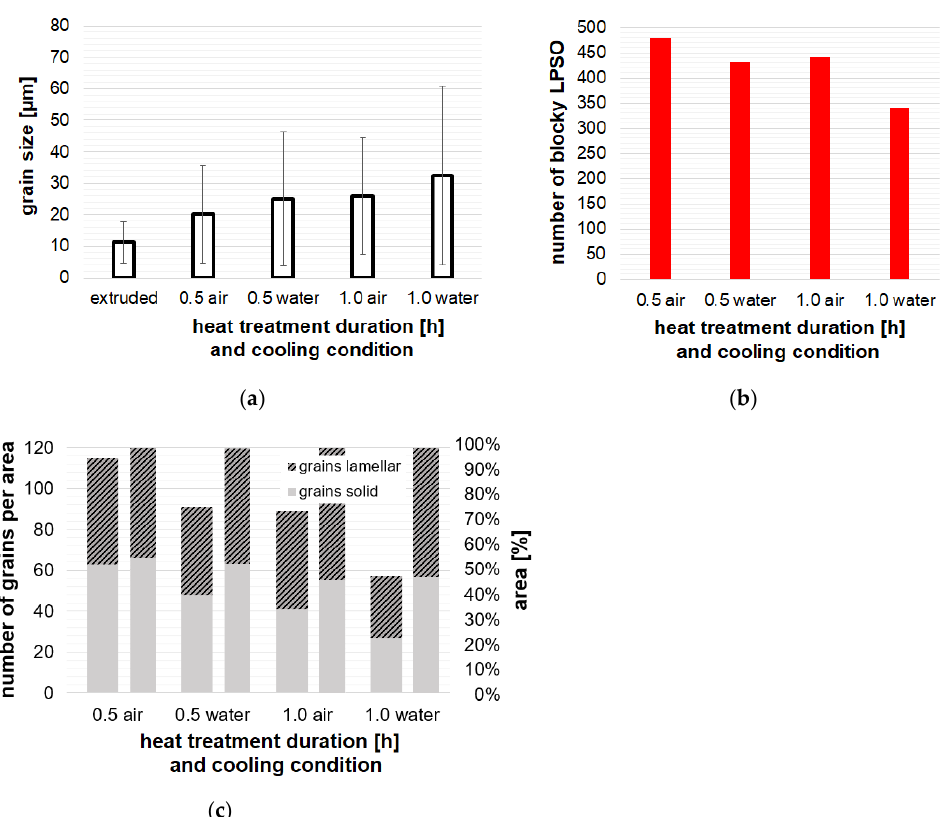
Figure 7. Microstructure depending on ( a ) grain size, ( b ) number of blocky LPSO and ( c ) number of grains per area of Mg matrix grains without LPSO lamellae (solid) and with LPSO lamellae — given solution heat treatment and cooled in air.